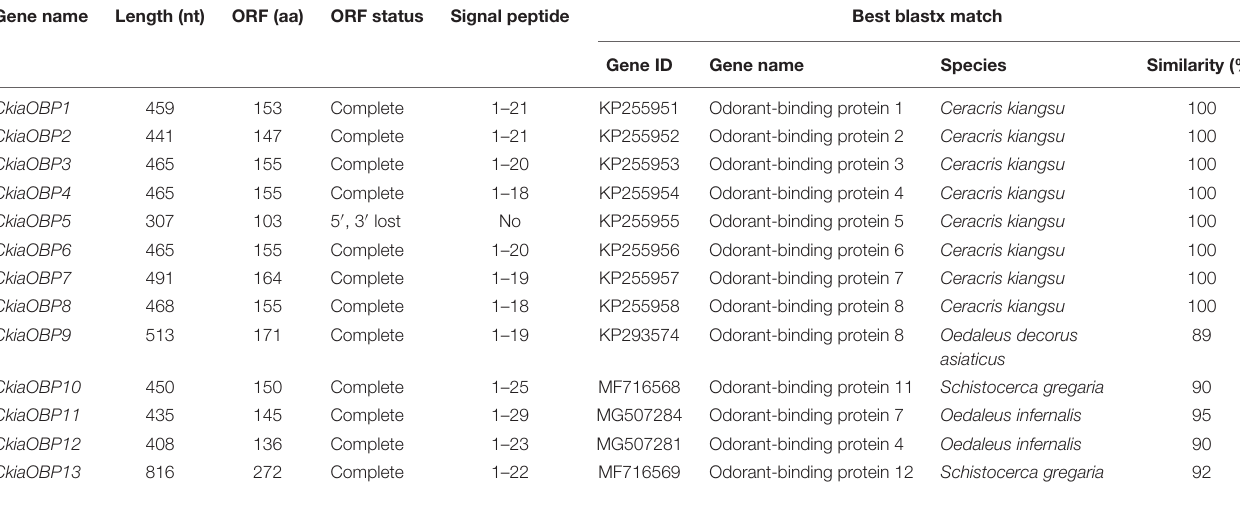
TABLE 3 | Summary of putative odorant binding proteins (OBPs) identified in C. kiangsu